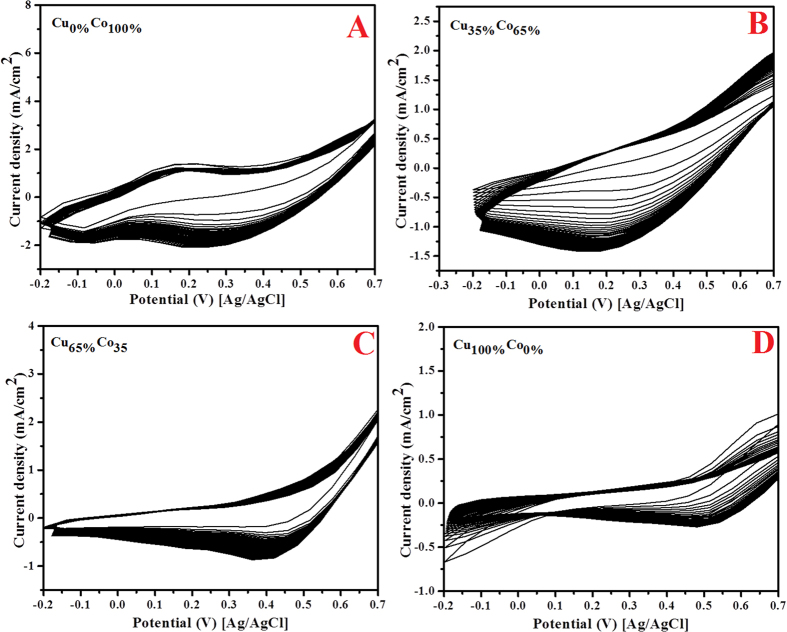
Cyclic voltammograms of the carbon nanofibers containing (A) Cu0%Co100% (B) Cu35%Co65% (C) Cu65%Co35%, and (D) Cu100%Co0% nanoparticles. Scan rate 100 mV/s, 1 M KOH.